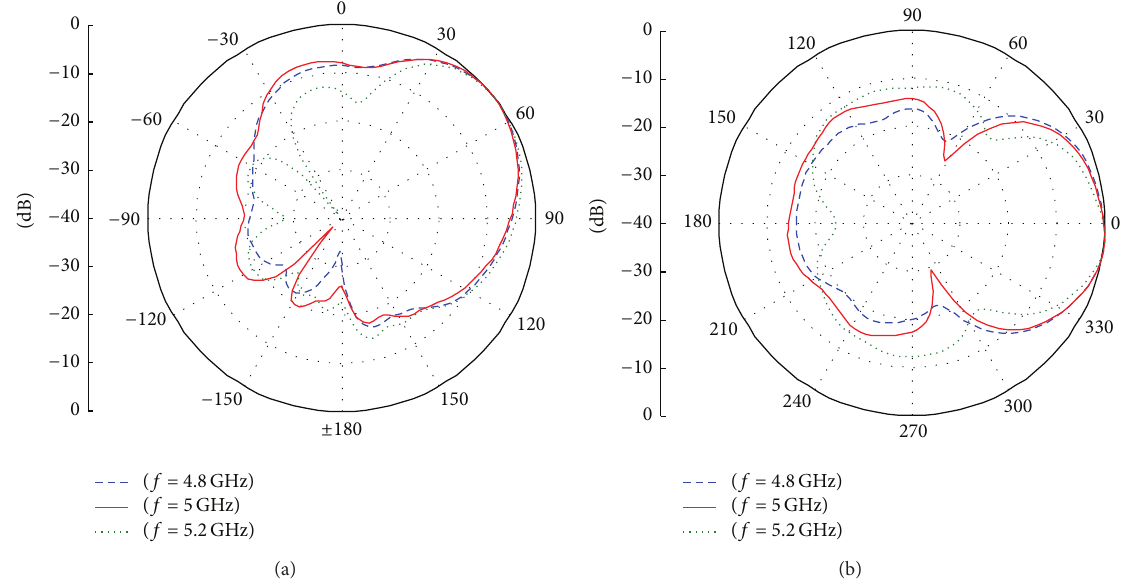
Figure 5: Measured elevation (a) and azimuth (b) radiation patterns for the Yagi array (Figure